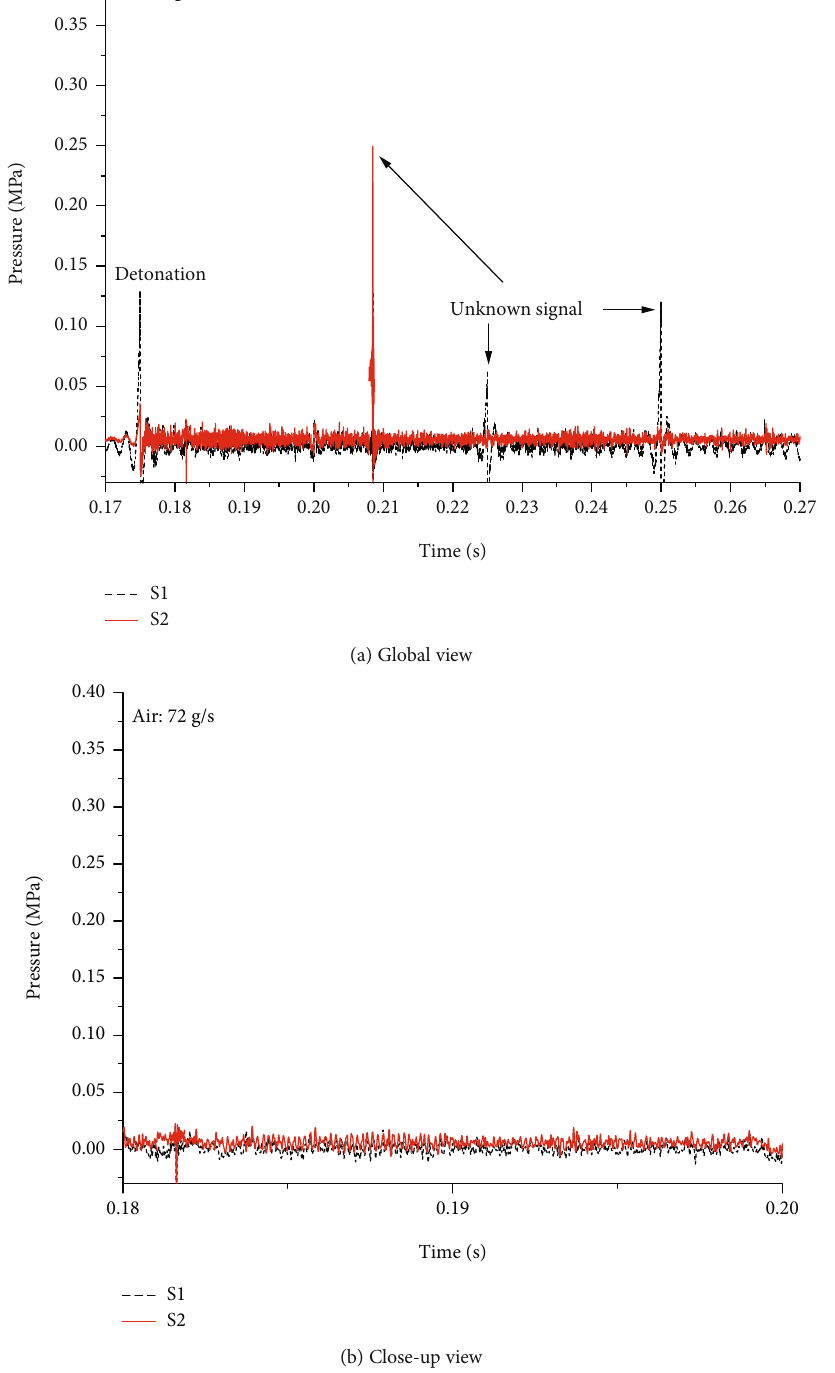
Figure 2: Pressure traces obtained by S1 and S2 for the air mass fl ow rate